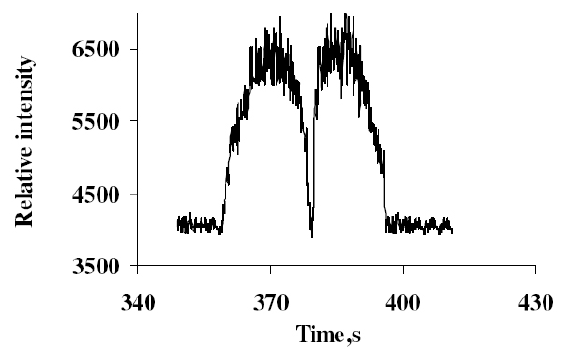
Figure 5. Separation of Cu (II) and Cu(EDTA)2- in microchip based μCE-MIP-OES system. Sample injection 3s. CE potential 2.2 kV.